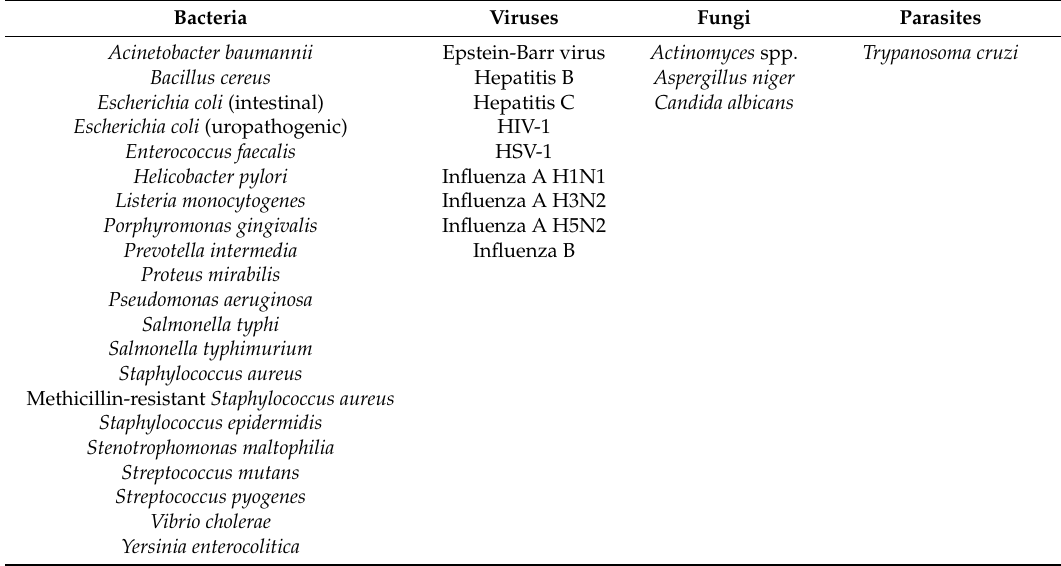
Table 3. Organisms affected by green tea